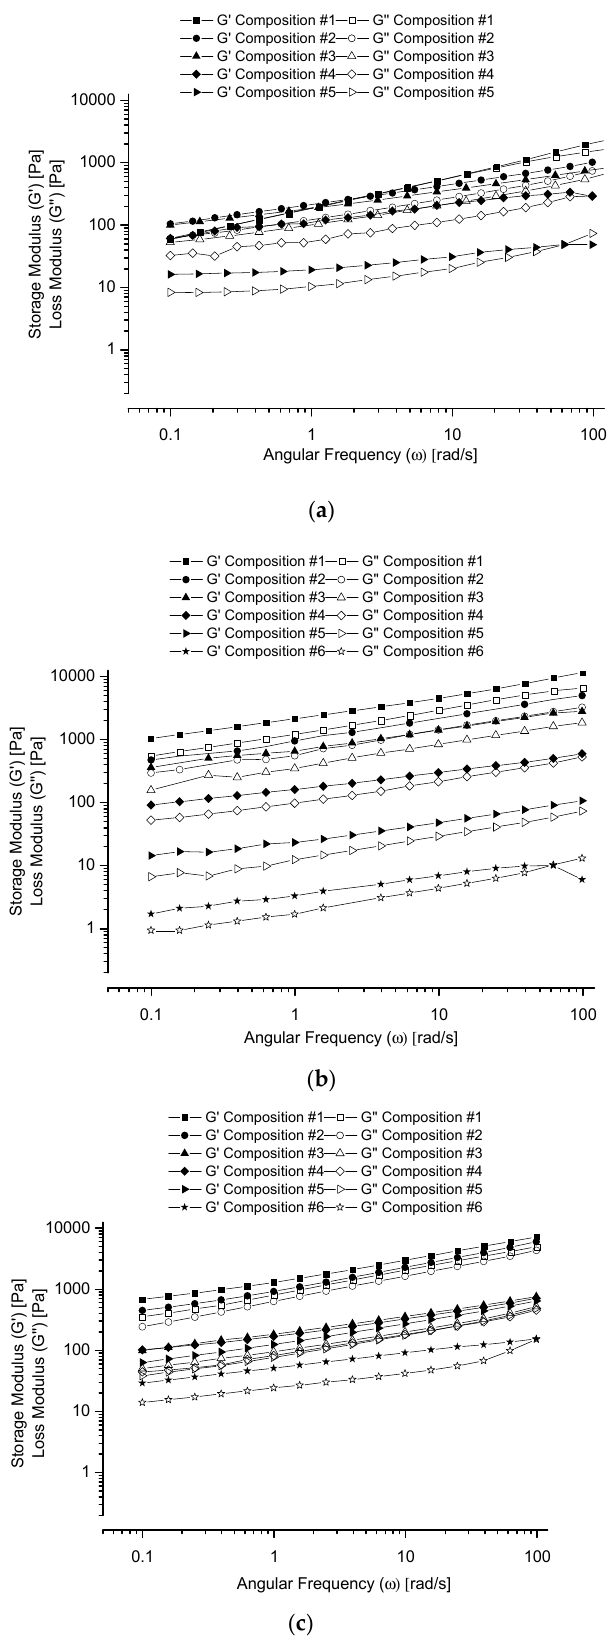
Figure 4. G’ and G’’ versus ω curves (in logarithmic scales) for the given co-hydrogel systems pre- Figure 4. G’ and G” versus ω curves (in logarithmic scales) for the given co-hydrogel systems pared in water ( a ), PBS buffer ( b ) and glycine/NaOH buffer ( c ). prepared in water ( a ), PBS buffer ( b ) and glycine/NaOH buffer ( c The network of this hydrogel system was self-assembled by individual PEG chains. It is a network at the molecular level, but not one formed by bundles of macromolecules as encountered in many chemically cross-linked hydrogel systems [18]. Therefore, the res- olution of the current scanning electron microscopy (SEM) method (in the order of mag- nitude of μ m) may not reveal the molecular-level structures of the co-hydrogel networks. Ideally, fluorescent labeling method [45] would provide direct evidence for the formation of the co-hydrogel system if fluorophores could be used to label the R f -groups of R f -PEG- R f and R f -PEG-PAA. However, our currently used materials and synthetic methods do not allow the straightforward fluorescent labeling to the R f -groups. Work in this direction would project a future research of chemistry. This research is to use the tensile test and rheological methods to indirectly address this issue. As discussed above, the experimental results of the tensile test on the control samples, compositions 8 to 10 in Table 1, demon- strate the necessity of the R f -group of R f -PEG-PAA to associate with the R f -cores formed by R f -PEG-R f . In addition, results of the rheometric measurements demonstrate the visco- elastic properties of the co-hydrogels with different R f -PEG-PAA/R f -PEG-R f ratios, which in turn verifies the association of the R f -group of R f -PEG-PAA with the R f -cores formed by R f -PEG-R f . 4. Conclusions R f -PEG-g-PAA copolymers were synthesized and integrated into the physically cross-linked R f -PEG-R f micellar network through self-assembly. Results of the tensile strength tests demonstrate that the co-hydrogel system possesses pH-sensitive mucoad- hesive properties. The mucoadhesion is stronger at low pH (4–5) and high pH (10.6) than in neutral condition, which shows the primary hydrogen bonding interaction and electro- static interaction between the PAA block and mucin. Experimental results of the control experiments indicate that the R f -group of the R f -PEG-g-PAA associated with the R f -cores of the R f -PEG-R f micelles, thus holding the PAA block though the PEG chain on the gel surface. Results of the rheological experiments demonstrate that the R f -PEG-g-PAA self- assembled into the R f -PEG-R f hydrogel network. The resulting co-hydrogels at different pH conditions could stay in physically cross-linked 3D networks with long-term physical dispersion stability although the number of physical cross-linkages between the micelles